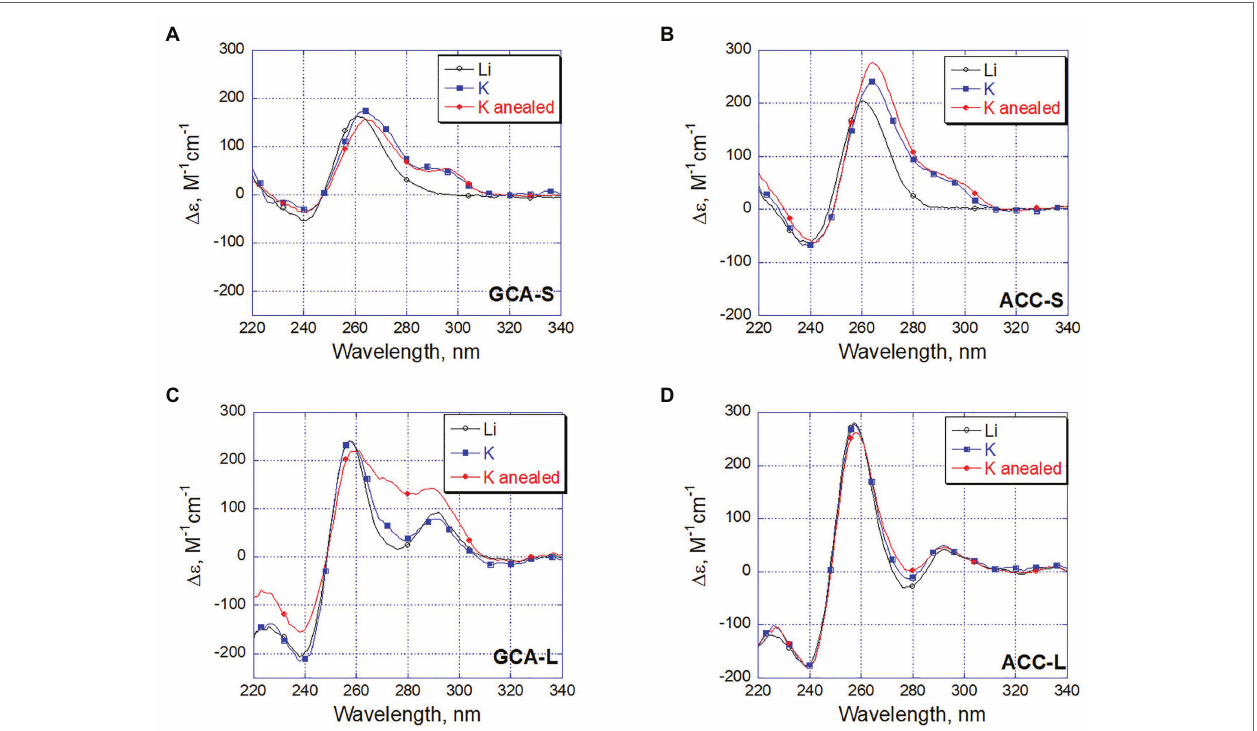
FIGURE 6 | Circular dichroism (CD) spectral changes reflects potassium dependent DNA refolding. The spectra were recorded for oligonucleotides GCA-S (A) , ACC-S (B) , GCA-L (C) , and ACC-L (D) at 1 µM concentration in 20 mM LiAc buffer pH 8.0 (black). The same sample after addition of 100 mM KCl and incubation 10 min at 20 ° C (blue) and subsequent fast annealing of the final solution